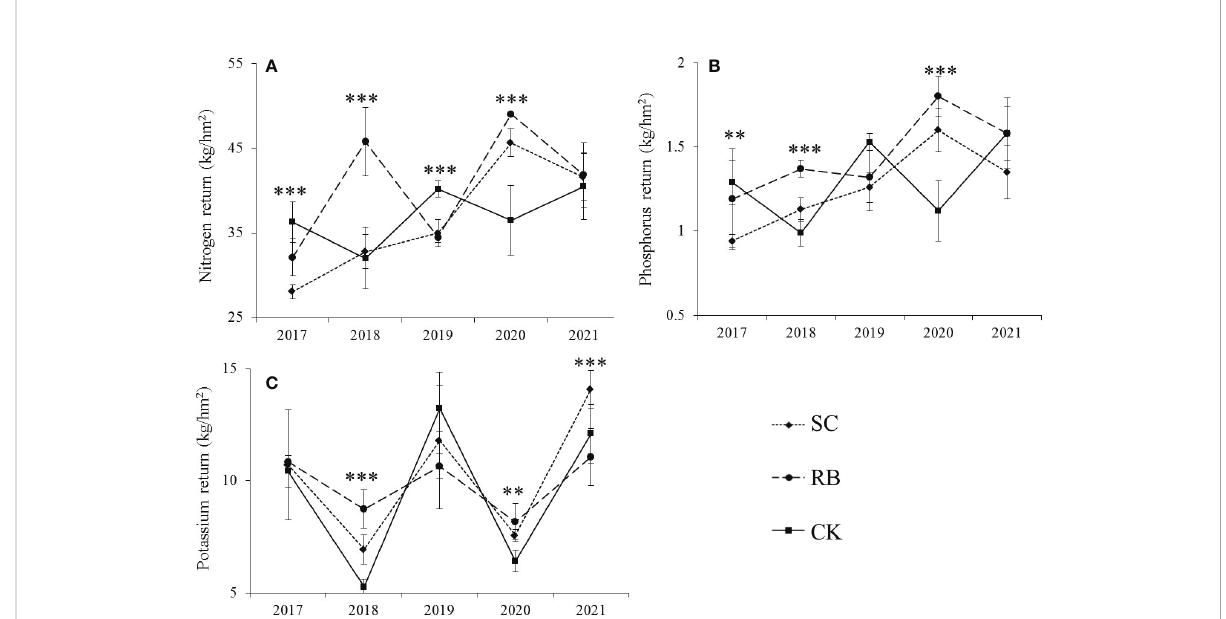
FIGURE 4 The nutrient return (A) nitrogen; (B) phosphorus; (C) potassium via litter to forest soil in strip cut plot (SC), reserved belt (RB), and control plots (CK). Error bars represent standard deviation (n=3). Asterisks indicate differences between study sites at different levels of signi fi